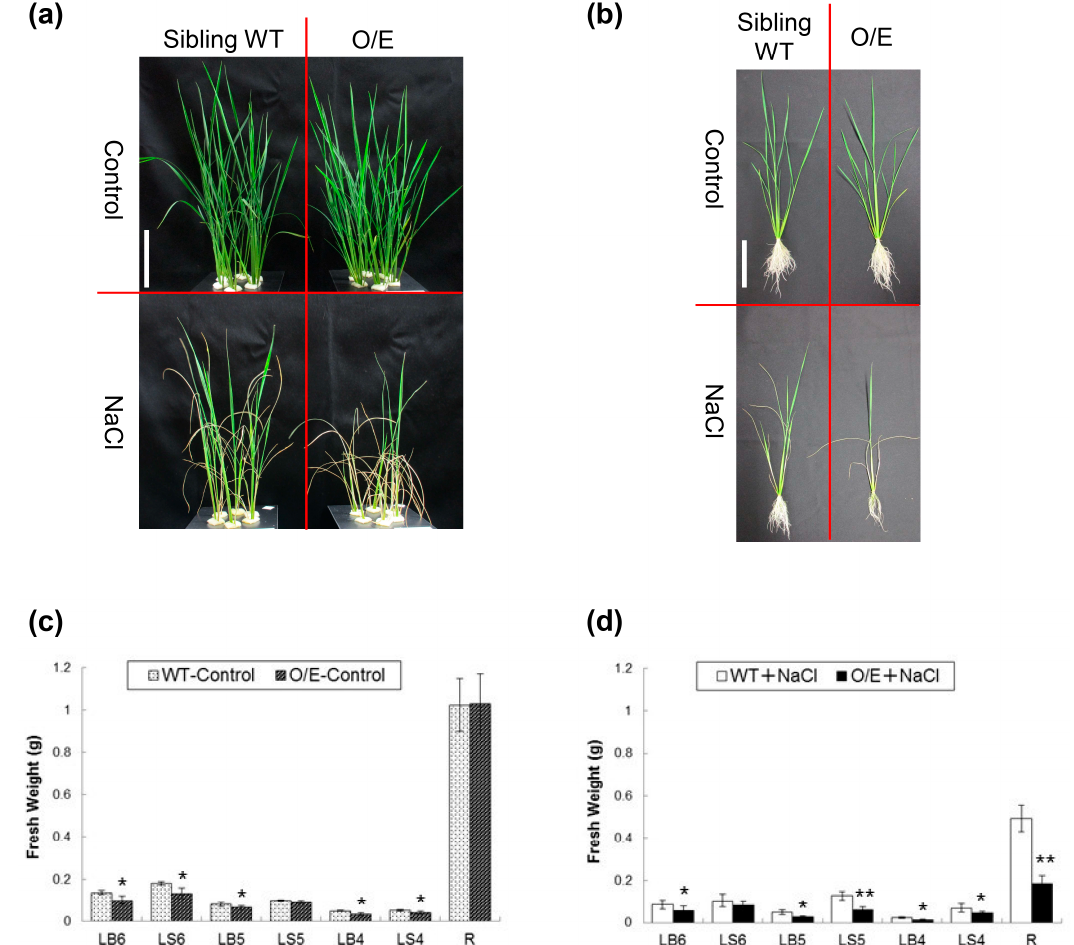
Figure 4. Increased salt sensitivity of the O/E line. ( a ) Pictures of O/E and sibling WT plants, which were prepared by hydroponic culture for approximately 2 weeks, and then treated with or without salt stress (a stepwise 25 mM increase in the NaCl concentration from 25 to 75 mM) for 9 days; ( b ) a representative plant from each condition mentioned in ( a ). Note that the white bars in ( a ) and ( b ) represent 10 cm; ( c ) fresh weights of leaf tissues and roots of O/E and WT plants, grown without salt stress ( n = 6, ±SD); ( d ) fresh weights of leaf tissues and roots of O/E and WT plants, treated with salt stress ( n = 6, ±SD). LB, LS, and R represent, respectively, leaf blades, leaf sheaths, and roots. Larger numbers on LB and LS represent younger leaves. Asterisks indicate significant differences between O/E and WT plants (Student’s t -test; * p < 0.05, ** p < 0.01).